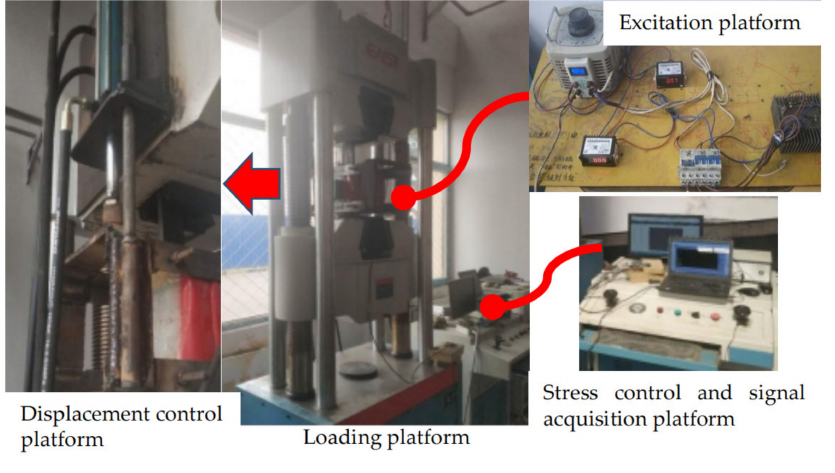
Figure 17. Experimental